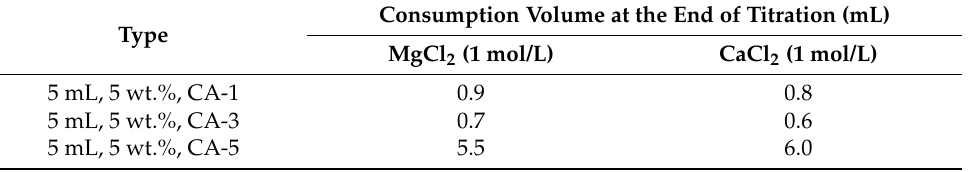
Table 3. Consumption volume of MgCl 2 and CaCl 2 by 5 mL chelating agent solution with a mass concentration of 5 wt.% at the end of